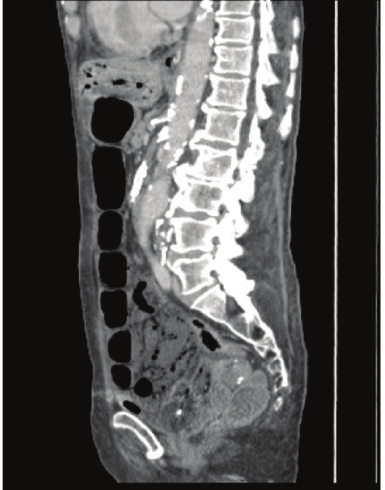
Figure 6: CT showing nonenhancement of the superior mesenteric artery following contrast. The celiac axis is heavily calcified with minimal contrast enhancement (Case